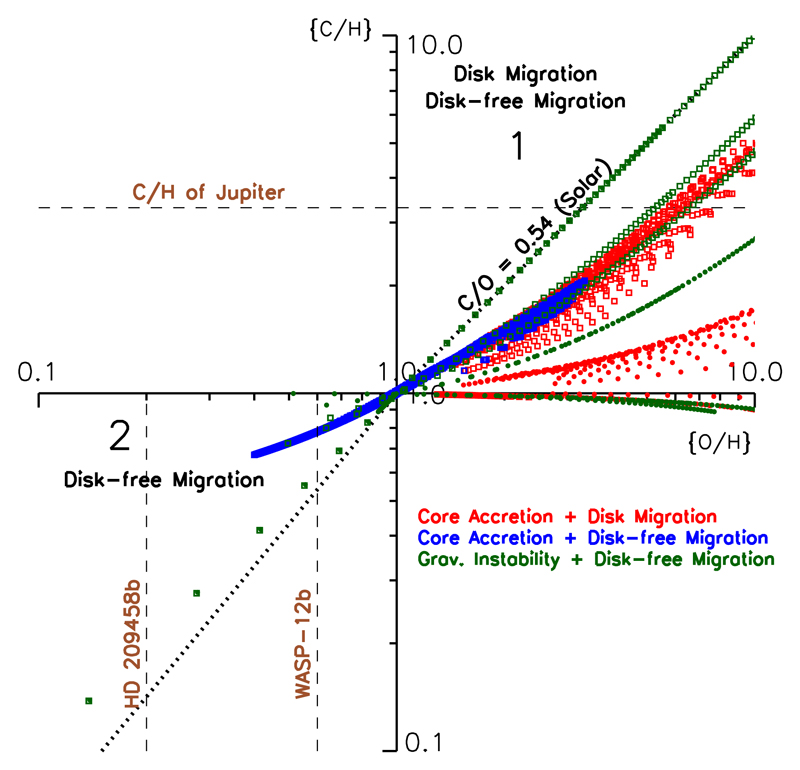
Predicted elemental O and C abundances in hot Jupiters from semi-analytic chemical models of hot Jupiter formation and migration (from Madhusudhan et al. 2014a). The axes show O/H and C/H abundances relative to solar values, and the colored symbols represent models with different formation-migration histories. Each dot represents a different model realization and shows the final O/H and C/H of the planet resulting from that model. The final elemental abundances in a planet depend critically on the amount of gas and solids accreted by the planet as well the region from which that material is accreted relative to the H2O, CO2, and CO snow lines, giving rise to the distinct loci of models in the O-C plane as shown. The results suggest that different migration mechanisms can cause different patterns of elemental enhancements in hot Jupiters